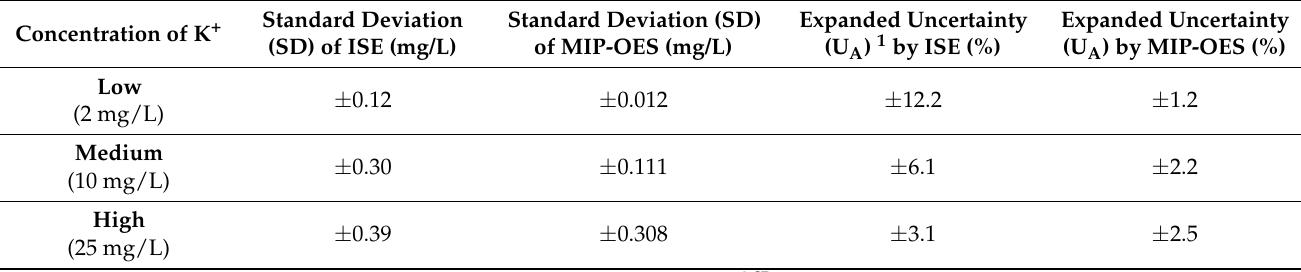
Table 5. Type A uncertainty estimation for the determination of potassium ion concentrations of 2 mg/L (low), 10 mg/L (medium), and 25 mg/L (high) using the ISE and MIP-OES methods.